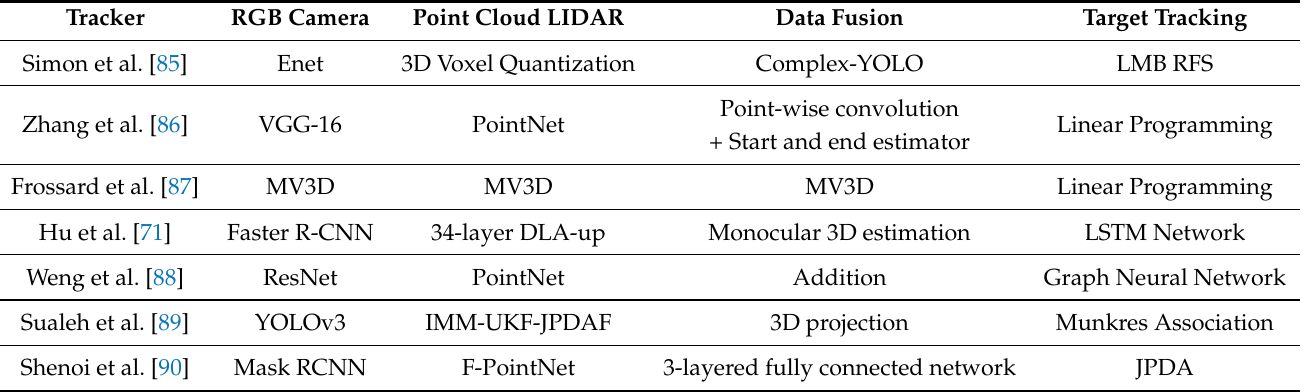
Table 3. Summary of the sensors fusion approaches used in 3D MOT